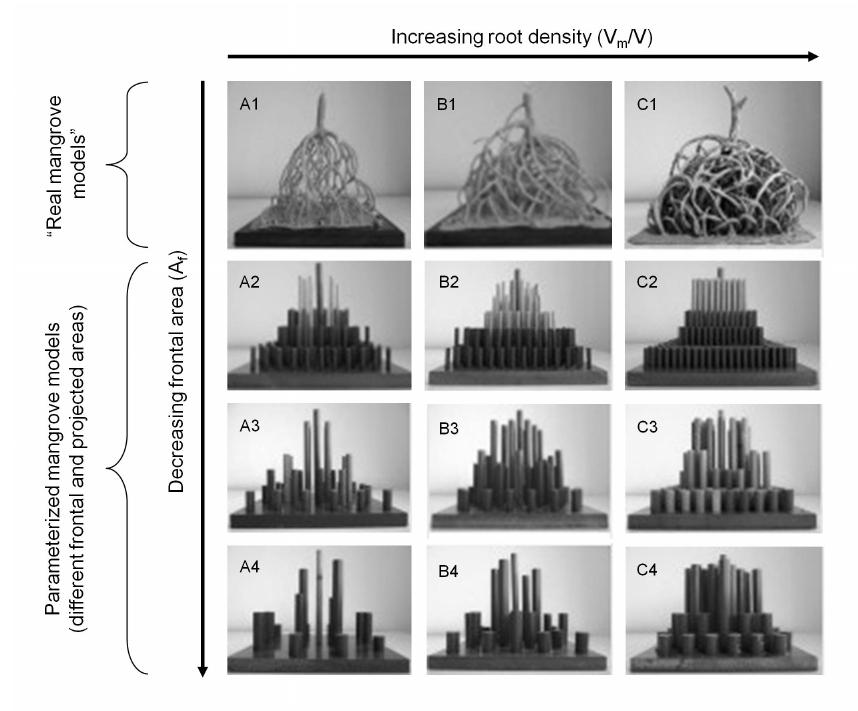
Fig. 2. “Real mangrove models” of different root density with corresponding parameterized mangrove models of varying frontal and projected areas. Root density in model groups A, B and C is